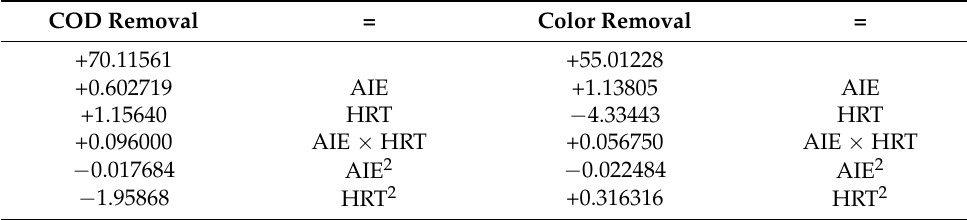
Table 3. Final equation in terms of actual factors for CFBS.